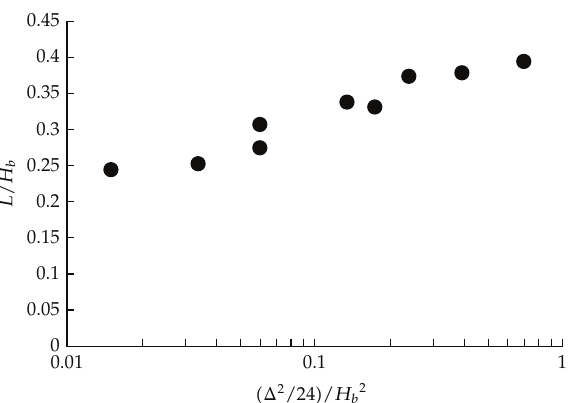
Figure 12: Relationship between coe ffi cients of filter operation and the distance between the concentration center and the real source point in each